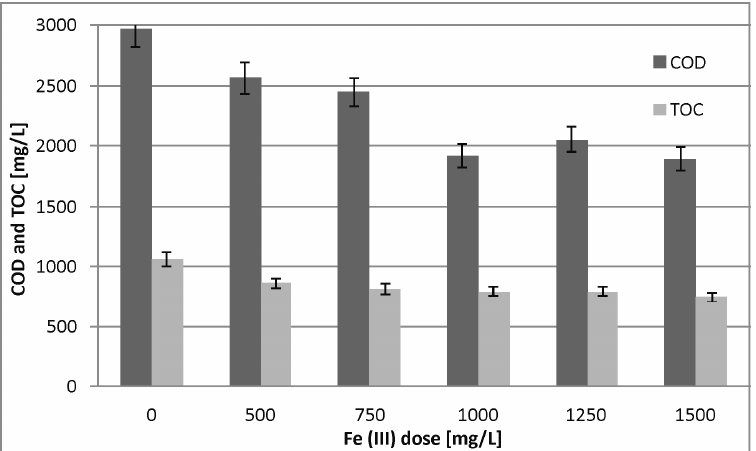
Figure 2. Total organic carbon (TOC) and chemical oxygen demand (COD) removal during coagulation with FeCl 3 in pH 6.0 for different coagulant